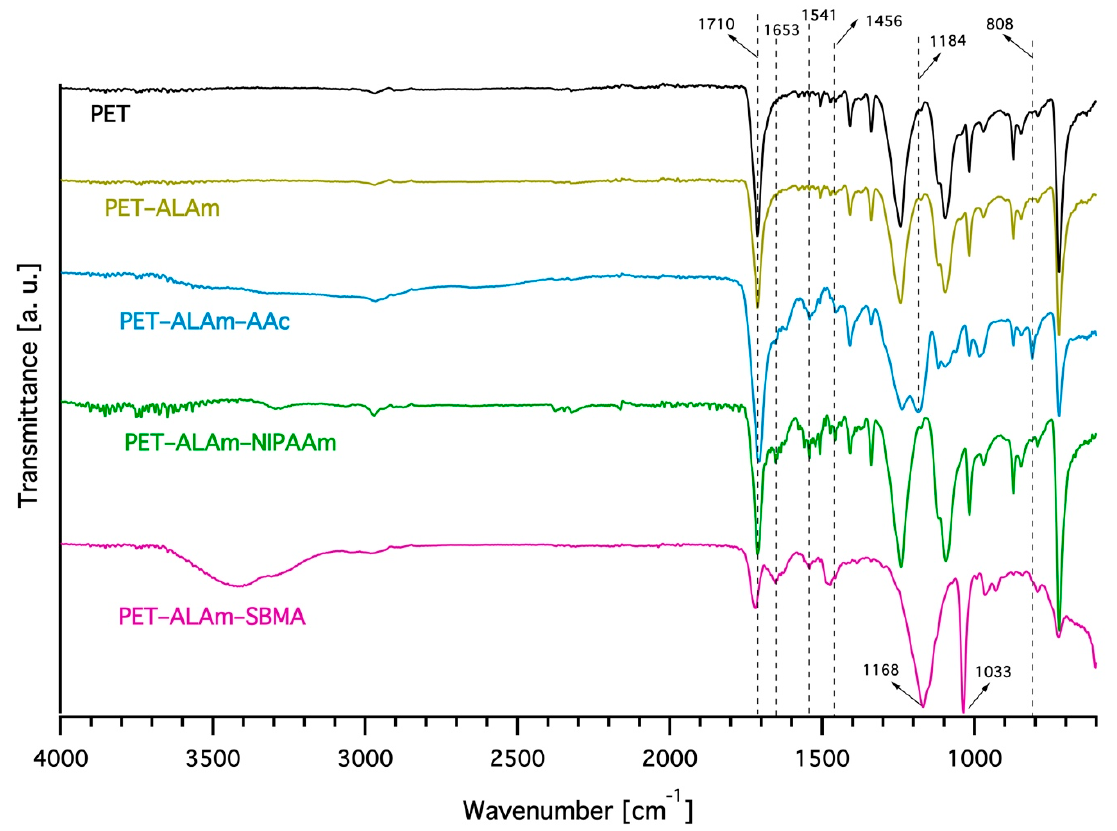
Figure 1. Attenuated total reflectance-fourier-transform infrared (ATR-FTIR) spectra of pristine PET, PET modified with allylamine (PET-ALAm), and hydrogel modified PET fabrics.